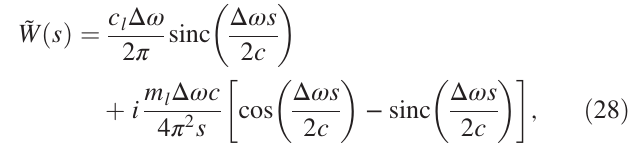
FIG. 22. The dipole kick factors of the single cell as a function of the synchronous frequency of the cell. The dots are values of the kick factors calculated via HFSS for cells A-G of the XARA structure given in Table II. The solid line is a linear fit to the data.